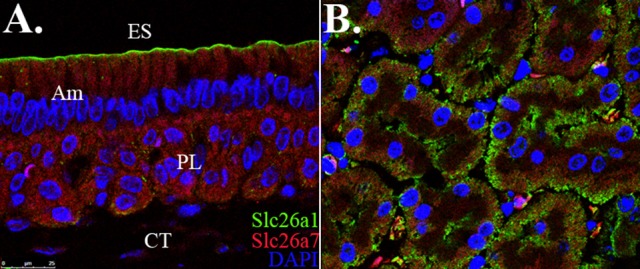
Colocalization analysis of Slc26a1 with Slc26a7. ES, Enamel space; Am, Ameloblast; PL, Papillary layer; CT, Connective tissue. (A) Colocalization of SLC26A1and SLC26A7 in maturation-stage ameloblasts by confocal microscopy at 63x magnification. SLC26A1 immunolocalized to the apical membrane of maturation-stage ameloblasts. SLC26A7 showed more expression in the cytoplasmic area in addition to an apical/subapical distribution. Apparent overlaps in fluorescence from SLC26A1 and SLC26A7 were not observed. (B) Tissue sections prepared from rat kidneys were stained with the same antibodies as a reference. All sections were counterstained with DAPI to highlight the nuclei (blue).